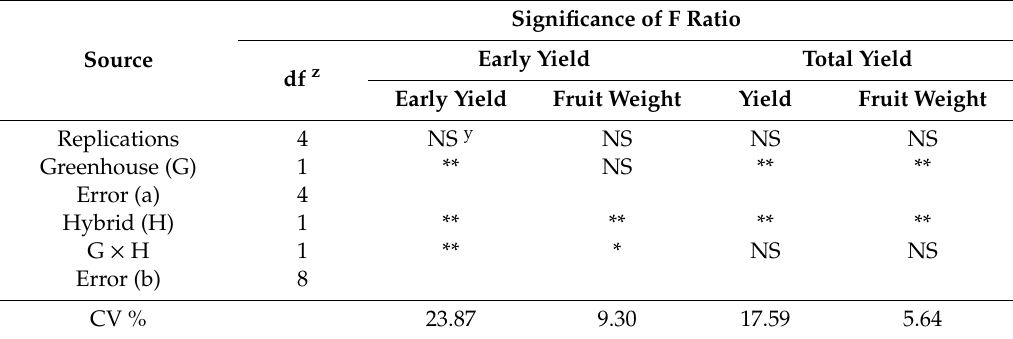
Figure 4. Production and yield data of the two tomato hybrids [MST (medium-sized) and ChT (cherry)] in the two greenhouses [DSSC (Dye-Sensitized Solar Cell) and CONV (Conventional)]: ( a ) Early yield; ( b ) total yield; ( c ) early mean fruit weight; ( d ) total mean fruit weight. Bars with different letters were significantly different by LSD at P ≤ 0.05. Table 2. Combined variance analysis of the production and yield data, as influenced by the greenhouse types [DSSC (Dye-Sensitized Solar Cell) and CONV (Conventional)] and the species of tomato hybrid [MST (medium-sized) and ChT